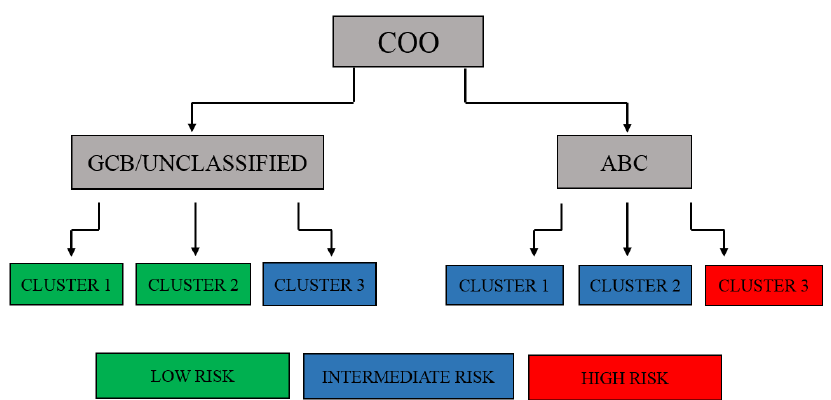
Figure 1. Prognostic categories of diffuse large B-cell lymphoma (DLBCL) based on cell of origin (COO) subtypes and microenvironment clusters. ABC, activated B cell-like; GCB, germinal centre B